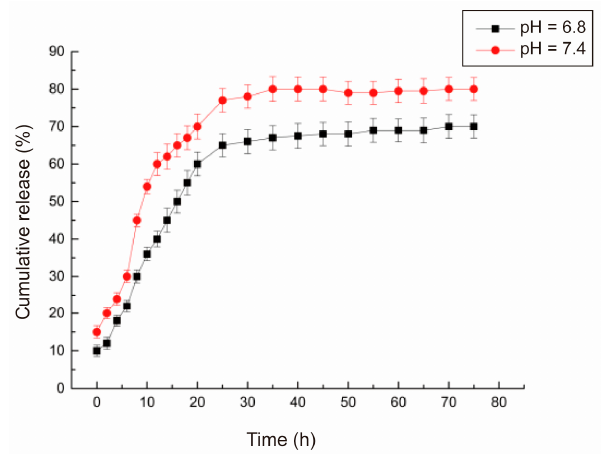
= 6.8) and blood (pH = 7.4)